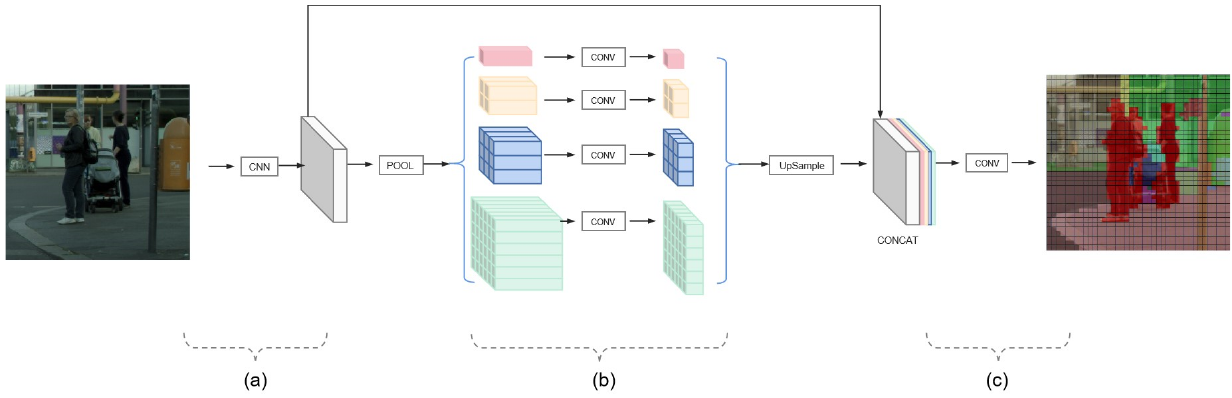
Figure 6. ( a – c ) The structure of the PSPNet model.